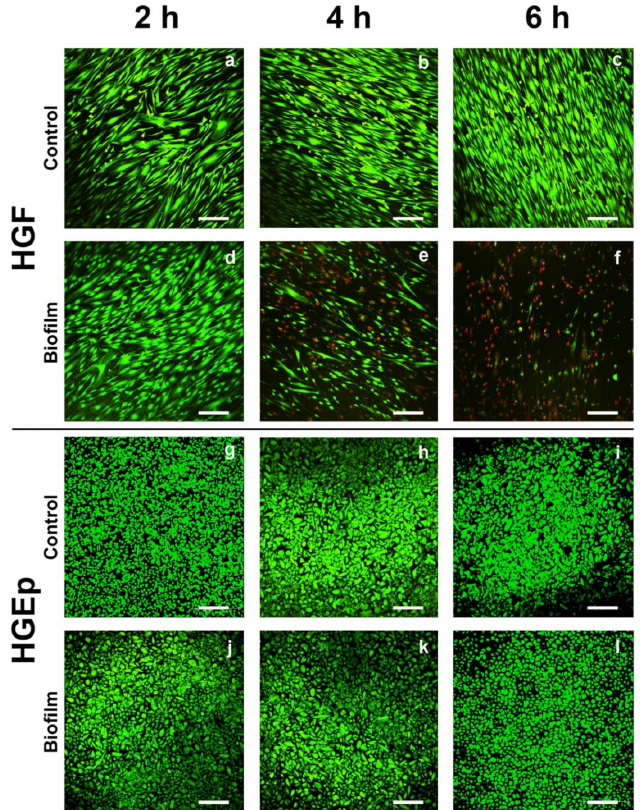
Figure 2. The vitality of gingival tissue cells after the S. oralis biofilm challenge. Tissue cells grown on titanium disks were co-cultured with the S. oralis biofilm or a control membrane for up to 6 h. Subsequently, the cells were stained for LIVE / DEAD. Green depicts live cells and red dead cells. The HGF remained vital in the control samples after 2, 4, or 6 h—( a ), ( b ), and ( c ), respectively. After 2 h of co-culture with the S. oralis biofilm, the vitality of HGF was similar to that of the control ( d ). Many dead cells were detected after 4 h ( e ) and almost all were dead after 6 h ( f ). The HGEp remained vital in the control samples after 2, 4, or 6 h—( g ), ( h ), and ( i ), respectively. The HGEps remained una ff ected after co-culture with the S. oralis biofilm for 2, 4, or 6 h—( j ), ( k ), and ( l ), respectively. Typical pictures from four to five independent experiments. Scale bars: 200 µ